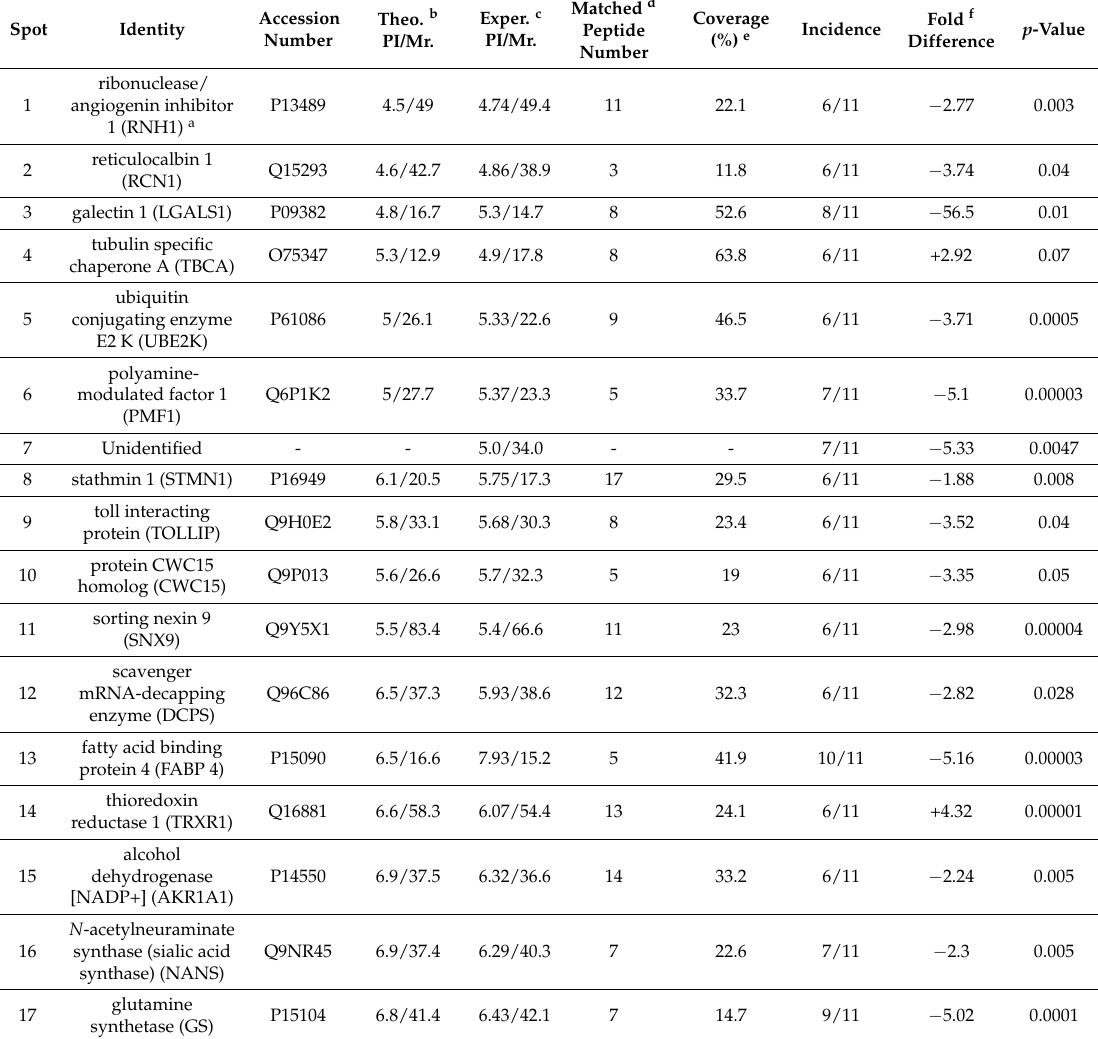
Table 1. Mass spectrometric data and identification of the galectin-1-associated de-regulated